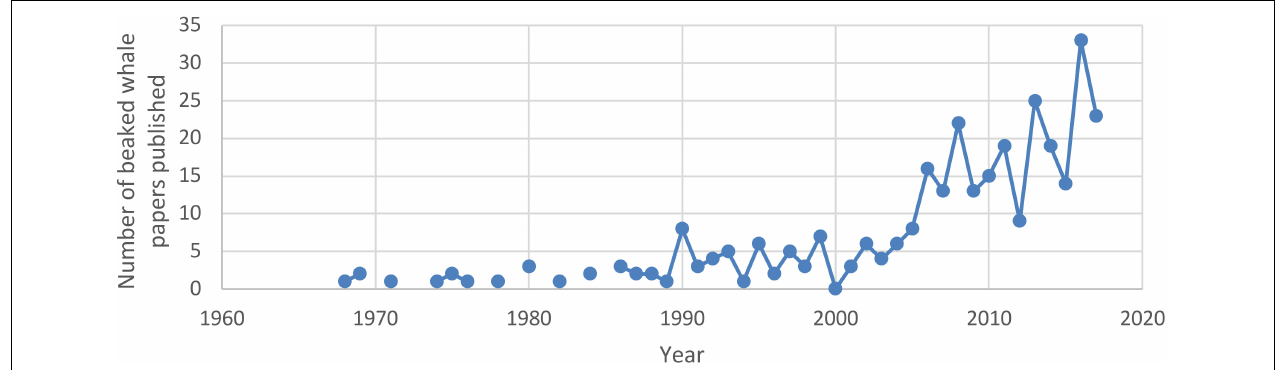
FIGURE 1 | Web of science search results for papers with “beaked whale” in title through 2017. Increasing publication rate in the 1990s and again in the late 2000s is clearly visible.